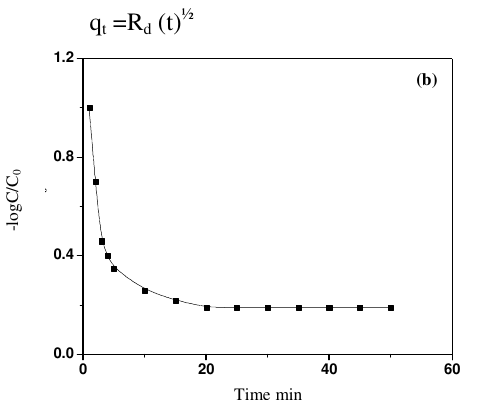
Figure 3. Rate of sorption of cadmium(II) onto reagent immobilized foams at 20±0.1 0 ºC. Where, R is the rate constant of intra-particle transport in mmol g -1 min -½ and q d sorbed cadmium(II) concentration (mol.g -1 ) at time t. The plots of q linear with correlation coefficient in the range of R 2 =0.975-0.980 in the initial stage of shaking time (up to 4-5 min) for cadmium(II) retention onto the reagent immobilized PUFs sorbents and deviate on increasing the shaking time. In the initial stage, the diffusion rate was high and decreased on passage of time indicating that the rate of the retention step is film diffusion at the early stage of extraction 23,24 . The values of R 0.67 mol.g -1 .min -1/2 for reagent immobilized PUFs in the initial stage up to 4.0 min of agitation time, respectively. Beyond 4-5 min shaking time, the values of R PUFs towards retention of cadmium(II) from the aqueous solution reduced to 0.23 g -1 .min –1/2 , confirm that, the intra-particle diffusion step can be a rate controlling